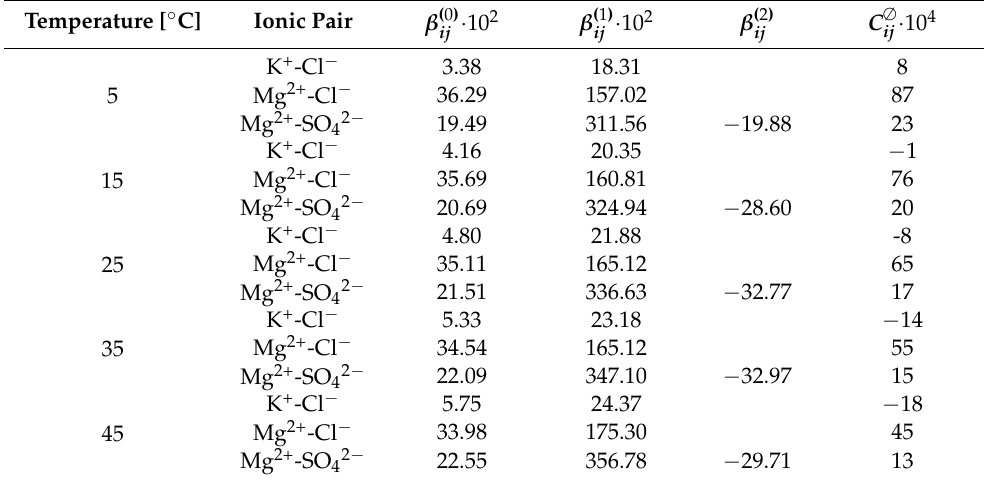
Table 1. Pitzer ionic interaction parameters of electrolytes KCl, MgCl 2 and MgSO 4 at different temperatures. Temperature [ ◦